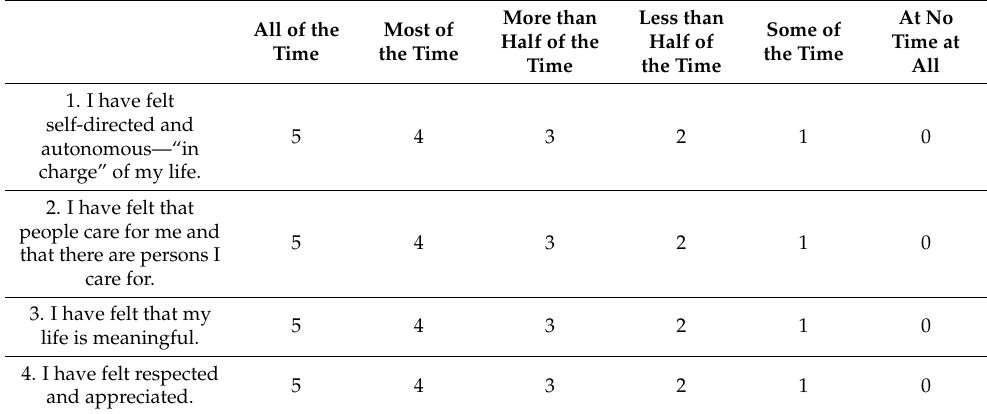
Table 3. The Human Condition-4—Satisfaction Index.